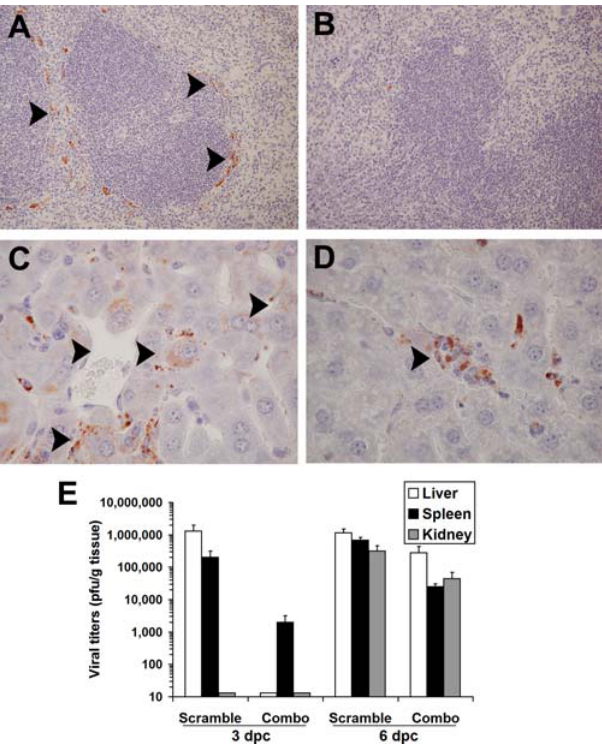
Figure 3. PMO Treatment Slows Viral Replication in Mice (A–D) C57BL/6 mice were challenged intraperitoneally with 1,000 plaque- forming units of EBOV following treatment with PMOs. Immunoperox- idase stain showing presence of viral antigen is brown with hematoxylin counterstain. Spleen (100 3 ) of a mouse treated with scrambled PMO (A) or the EBOV VP24, VP35, and L PMOs (B) 3 d after EBOV infection. Diffuse staining pattern in the livers (600 3 ) of the scrambled PMO-treated mice (C) on day 6 of EBOV infection, compared with focal areas of infection in the mice treated with the combination of PMOs (D). (E) Viral titers in tissues from mice treated with a combination of 3 PMO and infected with 1,000 pfu of EBOV. Samples of the liver, spleen, and kidney were taken at 3 d or 6 d post challenge (dpc), macerated, and analyzed for viral titer using plaque assay. The data are presented as the